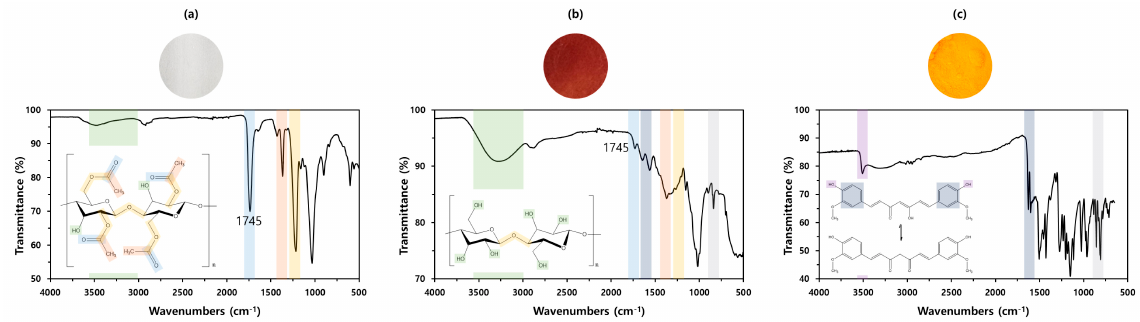
Figure 3. FT-IR spectra of: ( a ) electrospun CA fiber sample; ( b ) cellulose fiber sample treated by the immersion in curcumin/NaOH ethanol solution; and ( c ) curcumin.